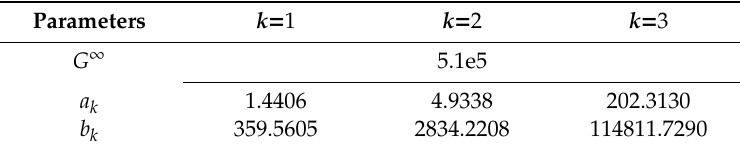
Table 2. Biot model parameters of the viscoelastic material, 30 ◦